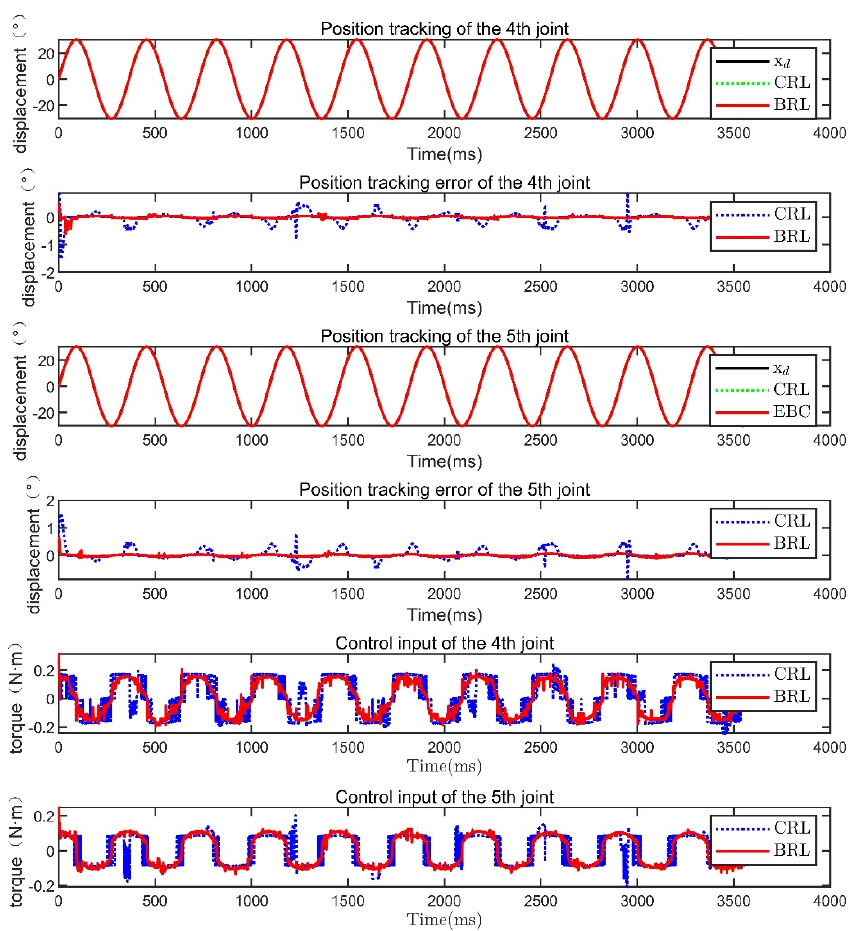
Table 4. Comparison results of controller performance indicators.